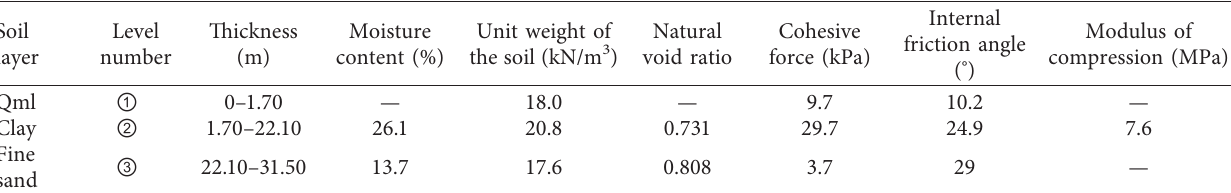
Figure 2: Pictures of case A1. (a) Jacking head. (b) Installation of machine head cutter. (c) Pipe hoisting. (d) Jacking head reached the receiving well. (e) The head of the pipe jacking machine was detached from the pipe joint. Table 3: Physical and mechanical properties of various layers.